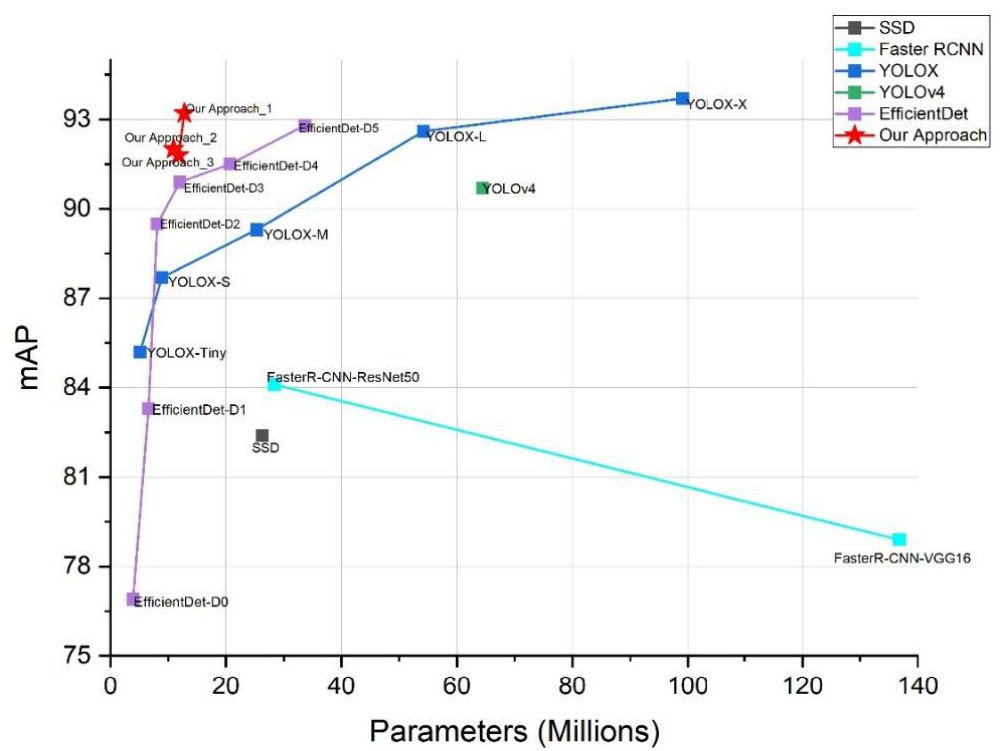
Figure 16. Model Size vs. mAP. Details are in Table 6. Table 6. Comparison of the VOC on the Pascal VOC 2007 and 2012 testing set, where bold numbers indicate the highest mAP in the column.